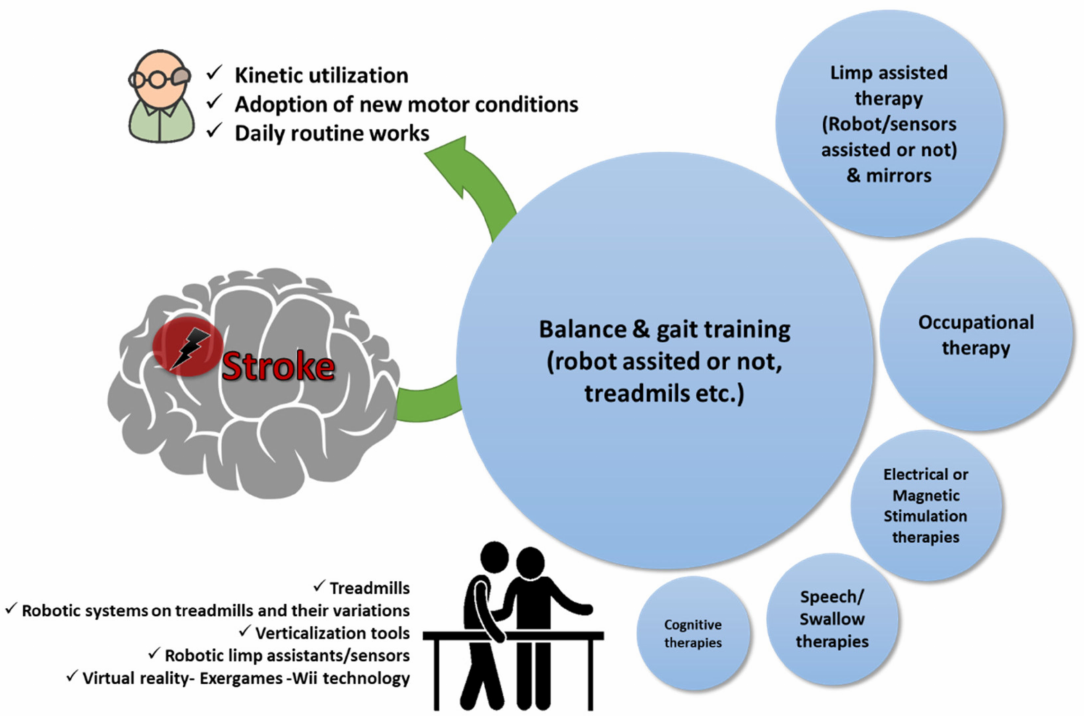
Figure 1. Physiotherapy goals in patients with stroke. A qualitative infographic of clinical trials in the literature regarding physiotherapy approaches in elders recovering from stroke with the incorporation of several pieces of state-of-the-art